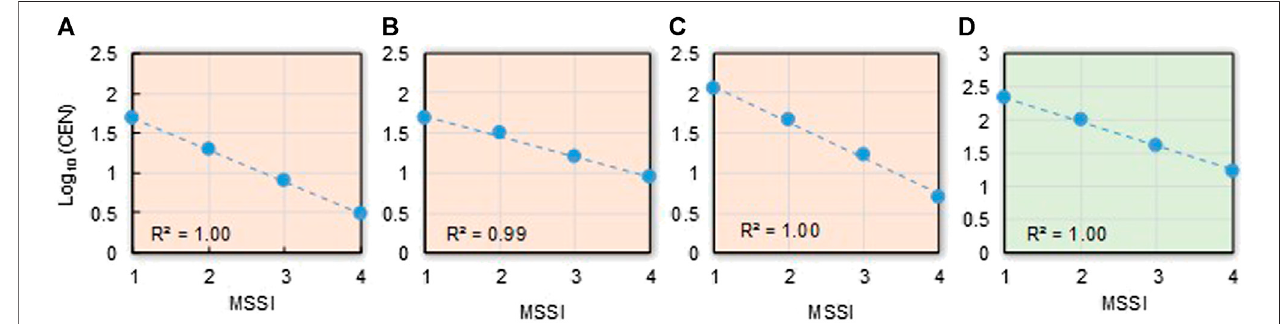
FIGURE 5 | Completeness of the reconstructed extreme hydrological events. Cumulative distribution of the logarithm of number of storm events vs. their Monthly Storm-Severity Index (MSSI) for sub-periods (pink colored graphs) (A) 1,000 – 1340 CE, (B) 1,341 – 1680 CE (C) 1,681 – 2019 CE, and (D) the entire dataset (green- coloured graph) 1,000 – 2019 CE for the Arno River